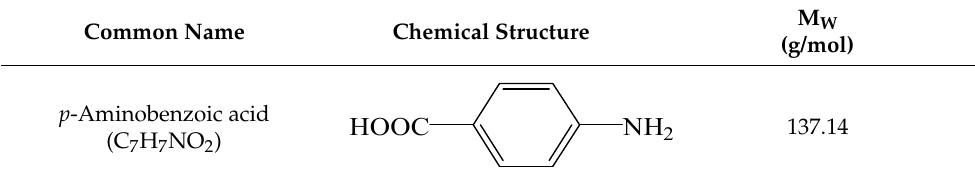
Table 1. Characteristics of the PABA.